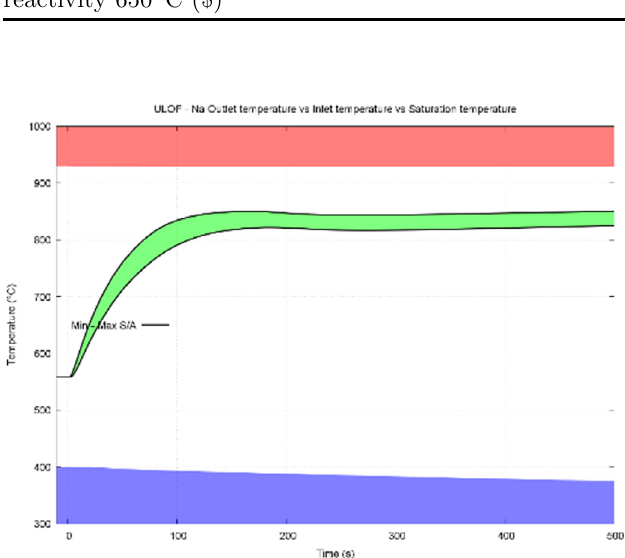
Fig. 7. Na outlet temperature.